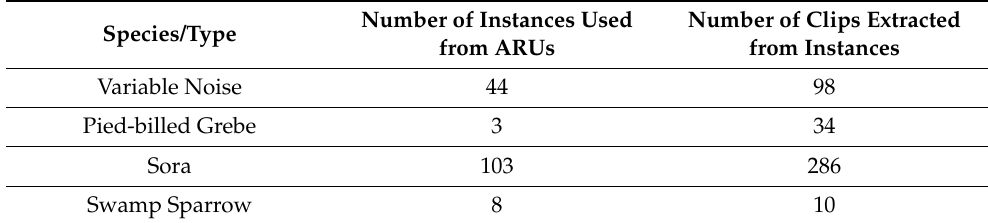
Table 2. Number of recordings used from ARUs by species/type and number of clips